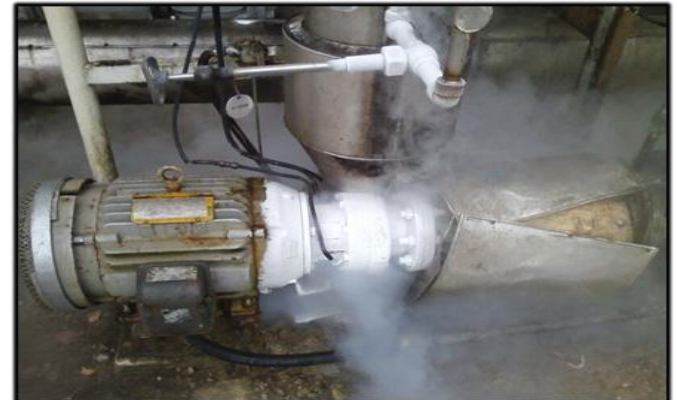
Figura 1A – Bomba Industrial.